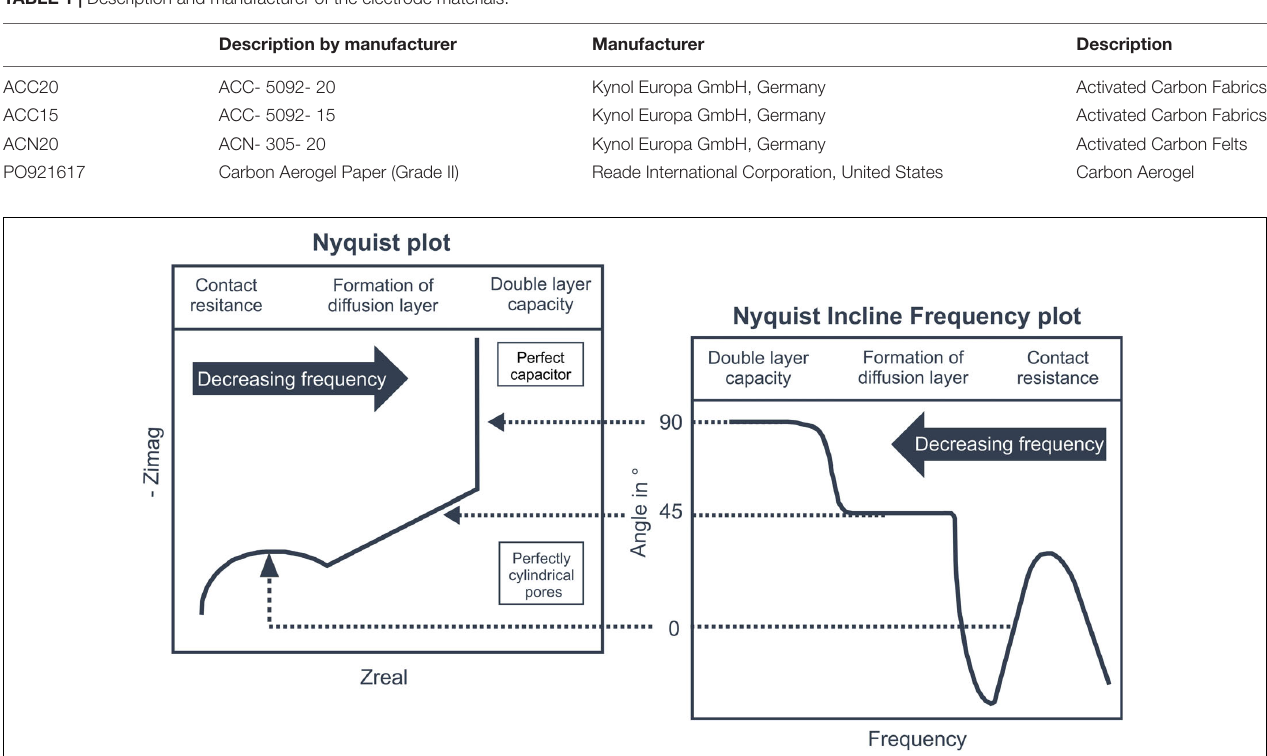
FIGURE 1 | On the left side a Nyquist plot can be seen, resulting from EIS of a typical porous electrode material used for CDI processes. On the right side the Nyquist Incline Frequency plot is presented. In both plots, three characteristic parts can be seen which are related to the contact resistance, coupled diffusion and diffusion layer formation in the pores, and finally the limiting double layer capacity. In contrast to the Nyquist plot, the NIF plot also contains direct information about the frequency ranges in which the mentioned physical effects dominate. Additionally, the slopes of the lines shown in the Nyquist plot and the corresponding angles in the NIF plot give detailed information about the materials